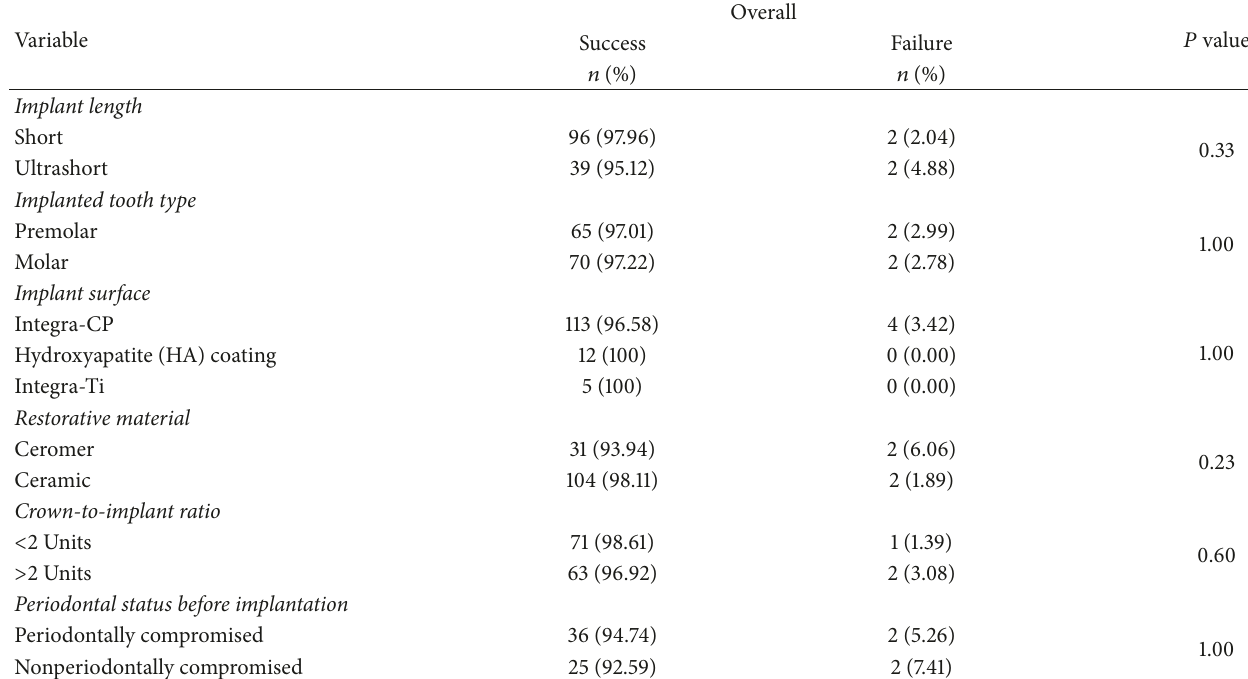
Table 2: Bivariate analysis of the success rate according to study included covariates.